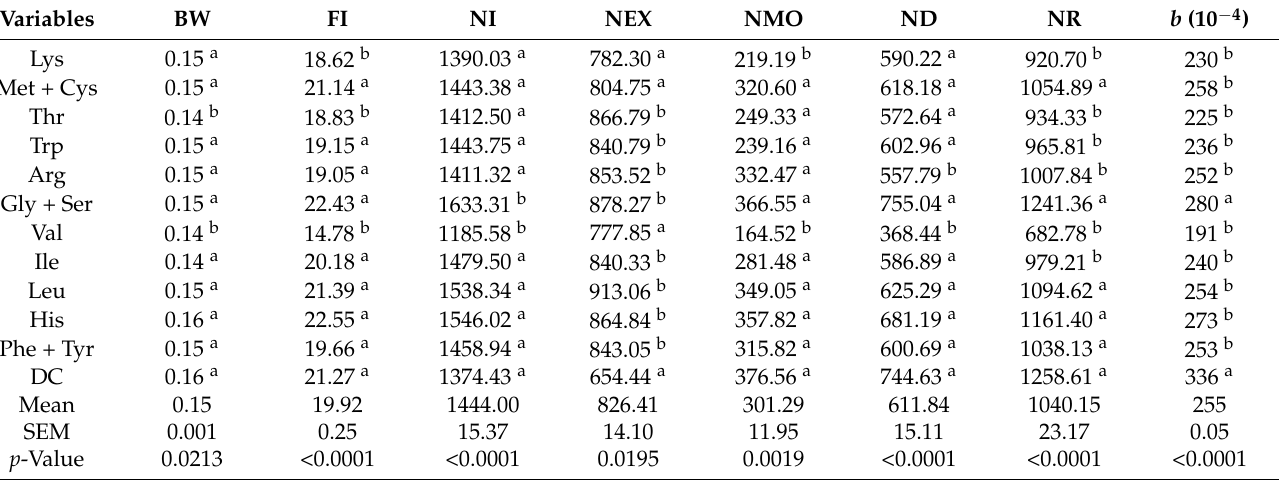
Table 7. Mean values for the effect of exclusion of an amino acid from the diet of Japanese quail breeders in a nitrogen balance trial.